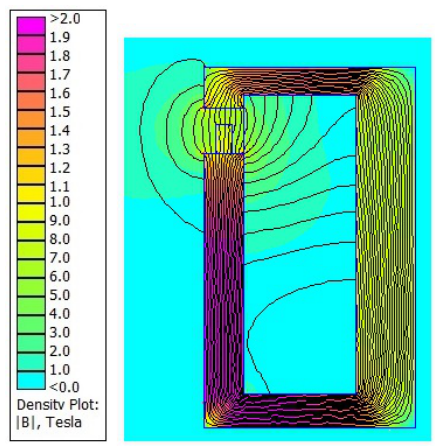
Figure 1. Flux density plot of the demonstrator magnet with a coil current density of 10 A mm − 2